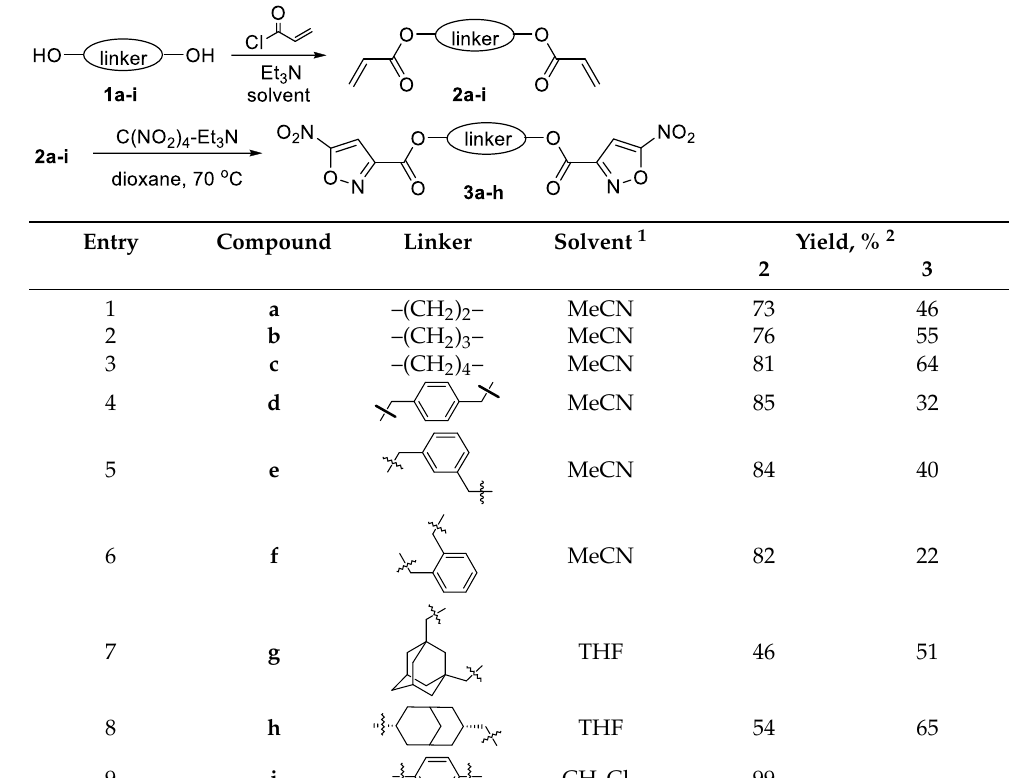
Table 1. Synthesis of electrophilic dienes 2 and bis(5-nitroisoxazoles) 3.